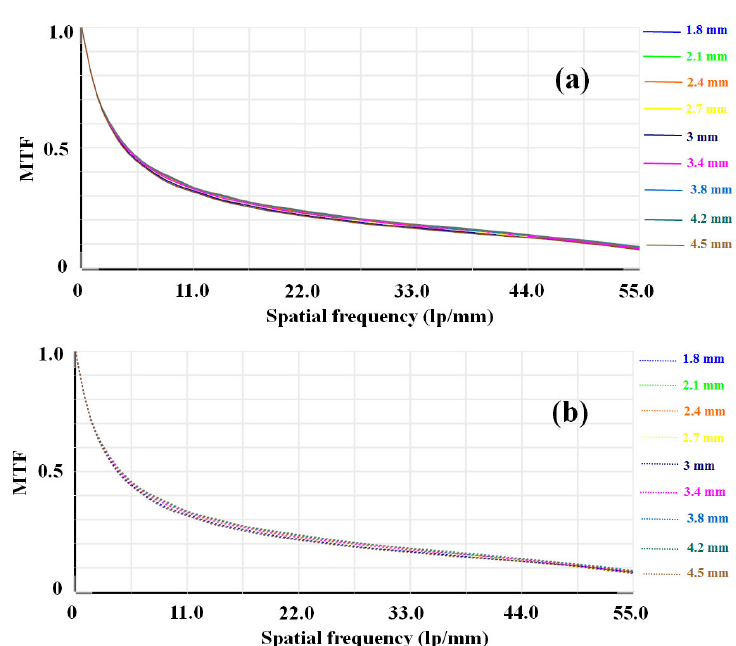
Figure 7. Calculated MTF curves of optical endoscope with phase mask (from Equations (9) and (11)), varied with object distances. The blue dotted-dashed line, green dashed line, red thin line, blue dotted line and purple thick line represent the object distances of 2 mm, 2.5 mm, 3.2 mm, 3.9 mm and 4.6 mm. The normalization factor, also referred as maximum spatial frequency, depends on the diameter of Airy disk of the optical system, which can be defined as D a . According to the parameters 4 × 1.22 × d o × λ of diameter of entrance pupil D a = 0.836 mm, objective distance d o = 2 mm and λ = 0.586 µ m, the calculated normalization factor is 146 lp/mm.